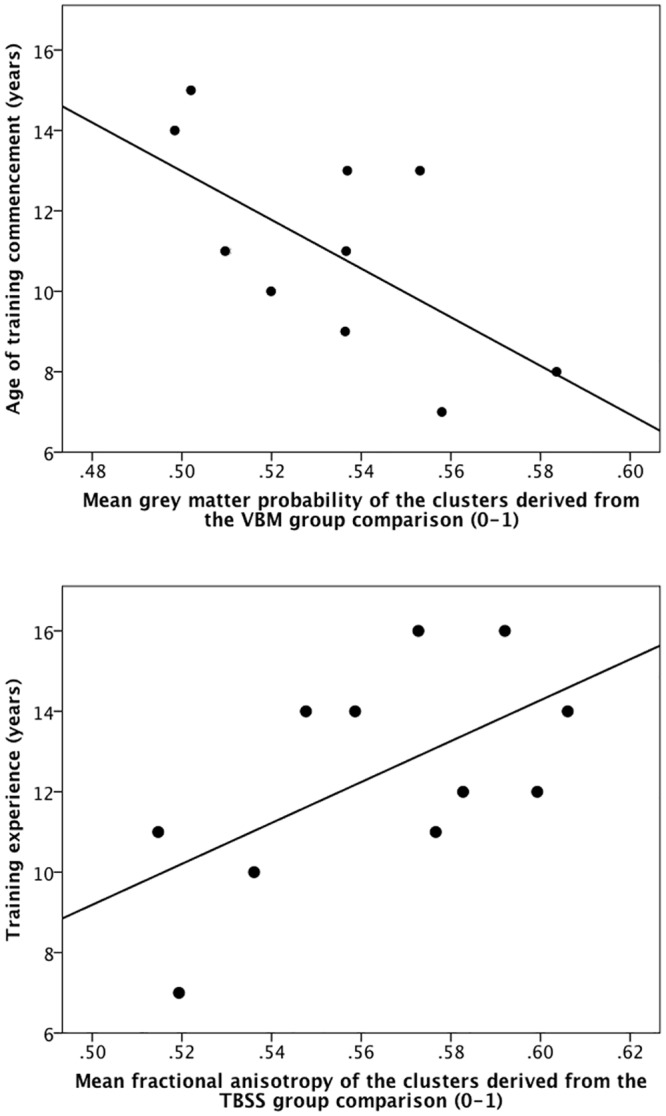
Associations between handball training-related measures and grey and white matter characteristics.Illustrated are the correlation between age of training commencement and mean grey matter density within the clusters revealed in the VBM group comparison (r = -0.64, R2 = 0.41, p = 0.018, one-tailed, n = 11, upper panel) as well as the correlation between years of training experience and mean fractional anisotropy within the clusters revealed in the TBSS group comparison (r = 0.59, R2 = 0.35, p = 0.027, one-tailed, n = 11, lower panel).